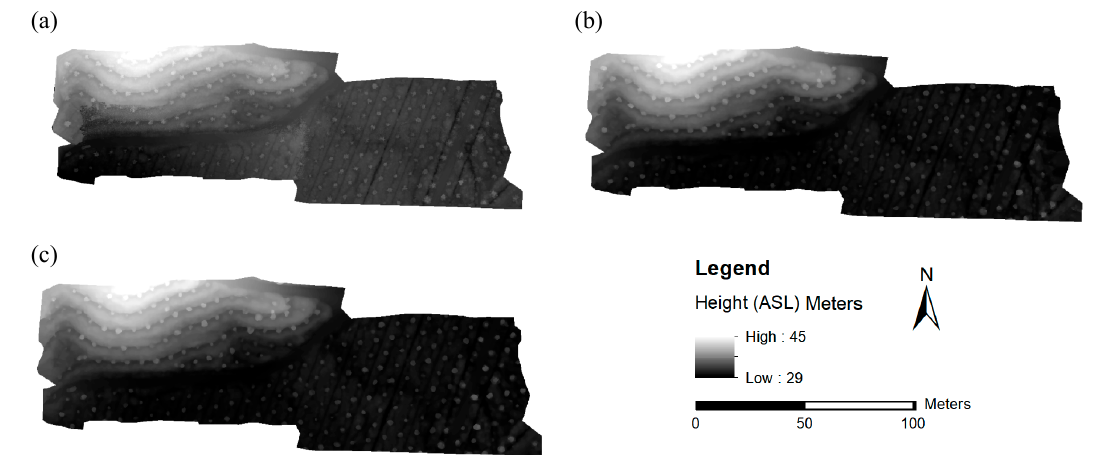
Figure A1. Point Clouds of the AOI at UAV altitude of ( a ) 20 m, ( b ) 60 m and ( c ) 80 m.